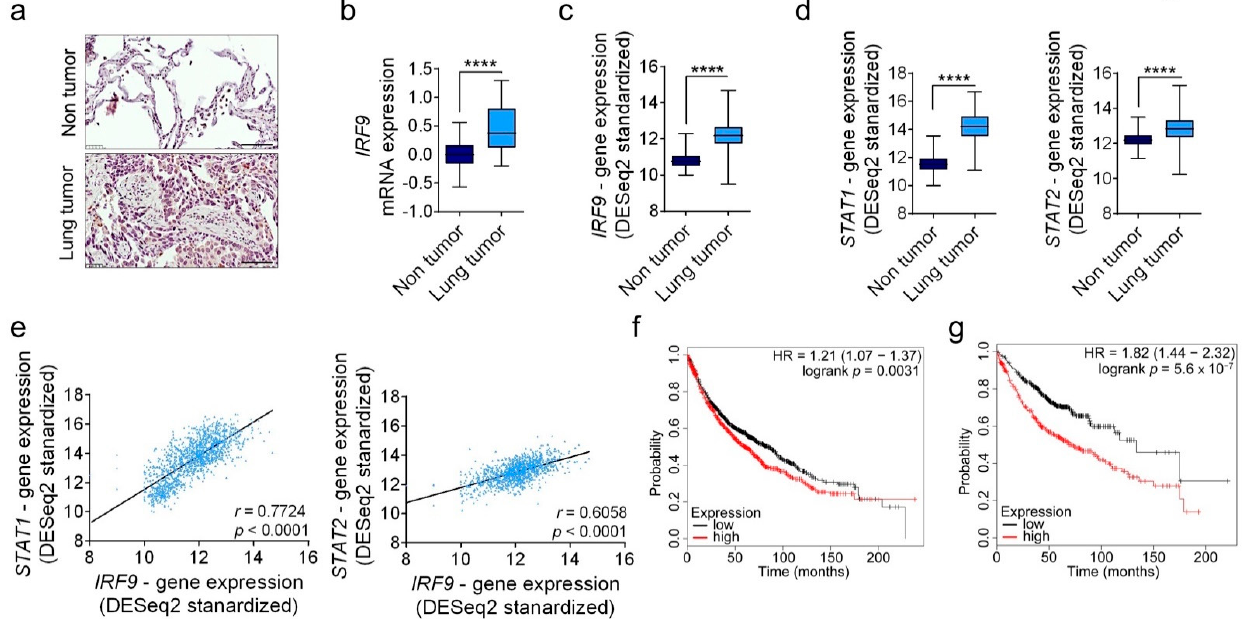
Figure 1. IRF9 expression is upregulated in patients with lung cancer and is associated with decreased survival. ( a ) Representative images of human lung sections stained with IRF9 antibody in LUAD ( n = 14) versus healthy tissues ( n = 3). Scale bar: 100 µm. ( b ) mRNA expression of IRF9 from LUAD and adjacent non-tumor tissues ( n = 11). ( c,d ) Gene expression profiles of ( c ) IRF9 , as well as ( d ) STAT1 and STAT2 , in non-tumor tissues ( n = 287) and patients with LUAD ( n = 573) from the TCGA TARGET GTEx study. ( e ) Scatter plots of IRF9 expression correlated with STAT1 or STAT2 expression in 1122 lung tumor samples from a TCGA dataset. The r value and two-tailed p value were calculated using Pearson’s rank correlation coefficients. ( f,g ) Kaplan–Meier curves for IRF9 expression associated with the survival of patients with ( f ) lung cancer ( n = 1926) and ( g ) LUAD ( n = 720) patients, divided by the median into high and low expression. Data are expressed as means ± standard error of the mean. Analysis was performed using Student’s t -test: **** p < 0.0001, LUAD compared to non-tumor tissues. Cancers 2021 , 13 , x